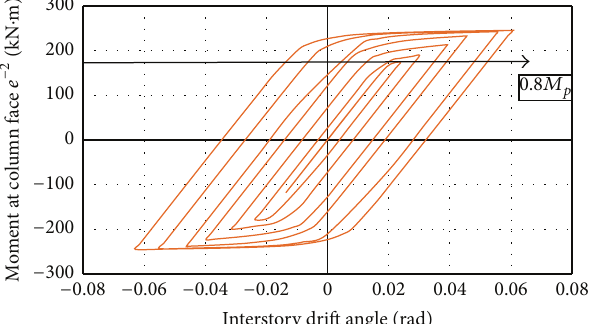
Figure 16: Moment at column face versus interstory drift